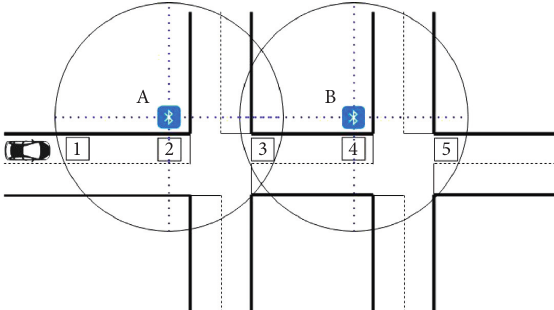
Figure 4: Illustration of Scenario one of a through vehicle on a signalised arterial link.